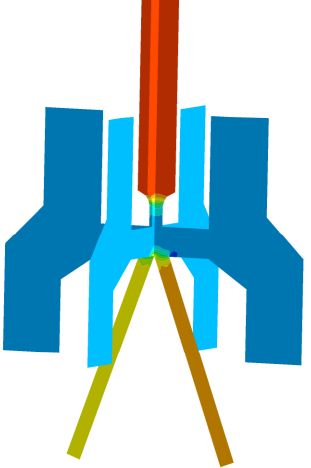
Figure 12. Pressure distribution diagram of jet pipe offset.